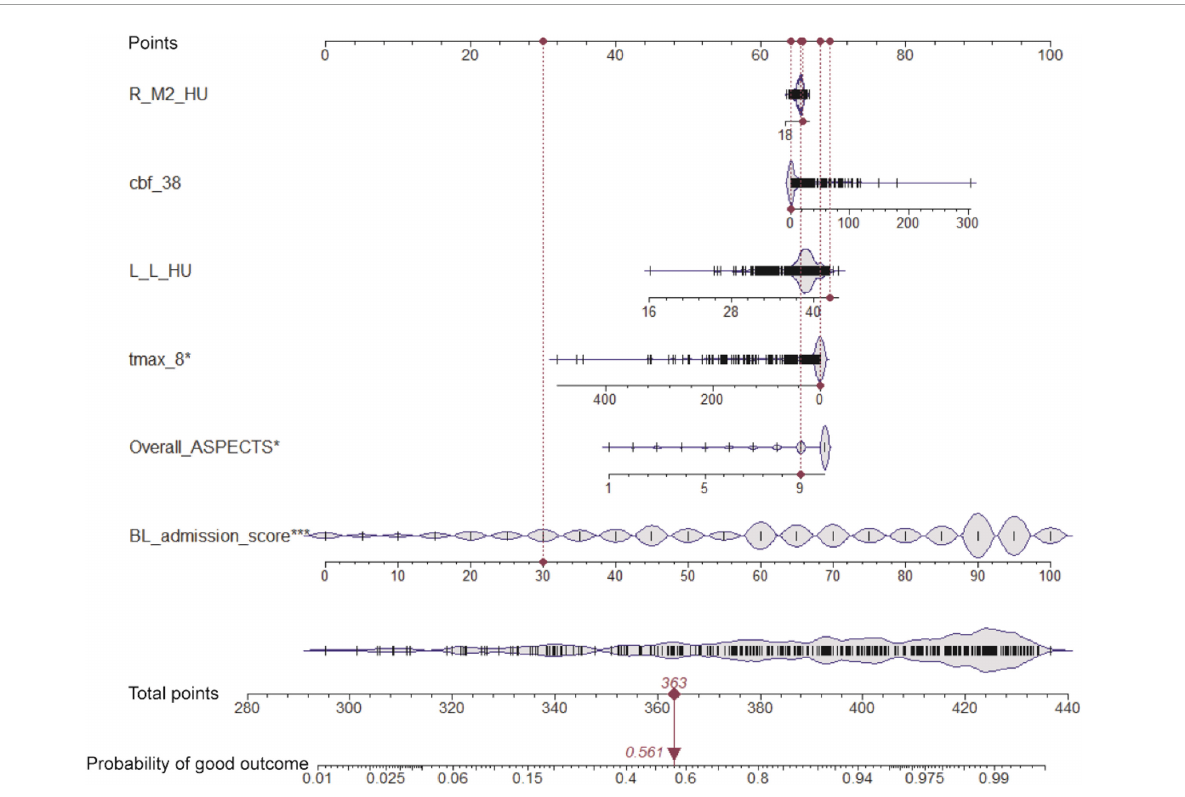
FIGURE2 Nomogram for predicting the clinical outcome. Six variables are included in the nomogram model. For the given sample shown above in the red line, each variable has a point, and the total point reflected the probability of a good outcome (discharge BI >